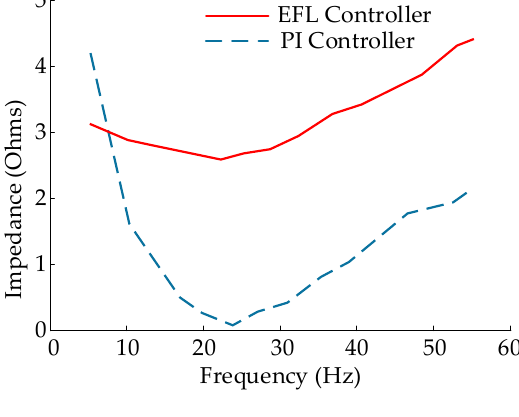
Figure 4. System side scans.